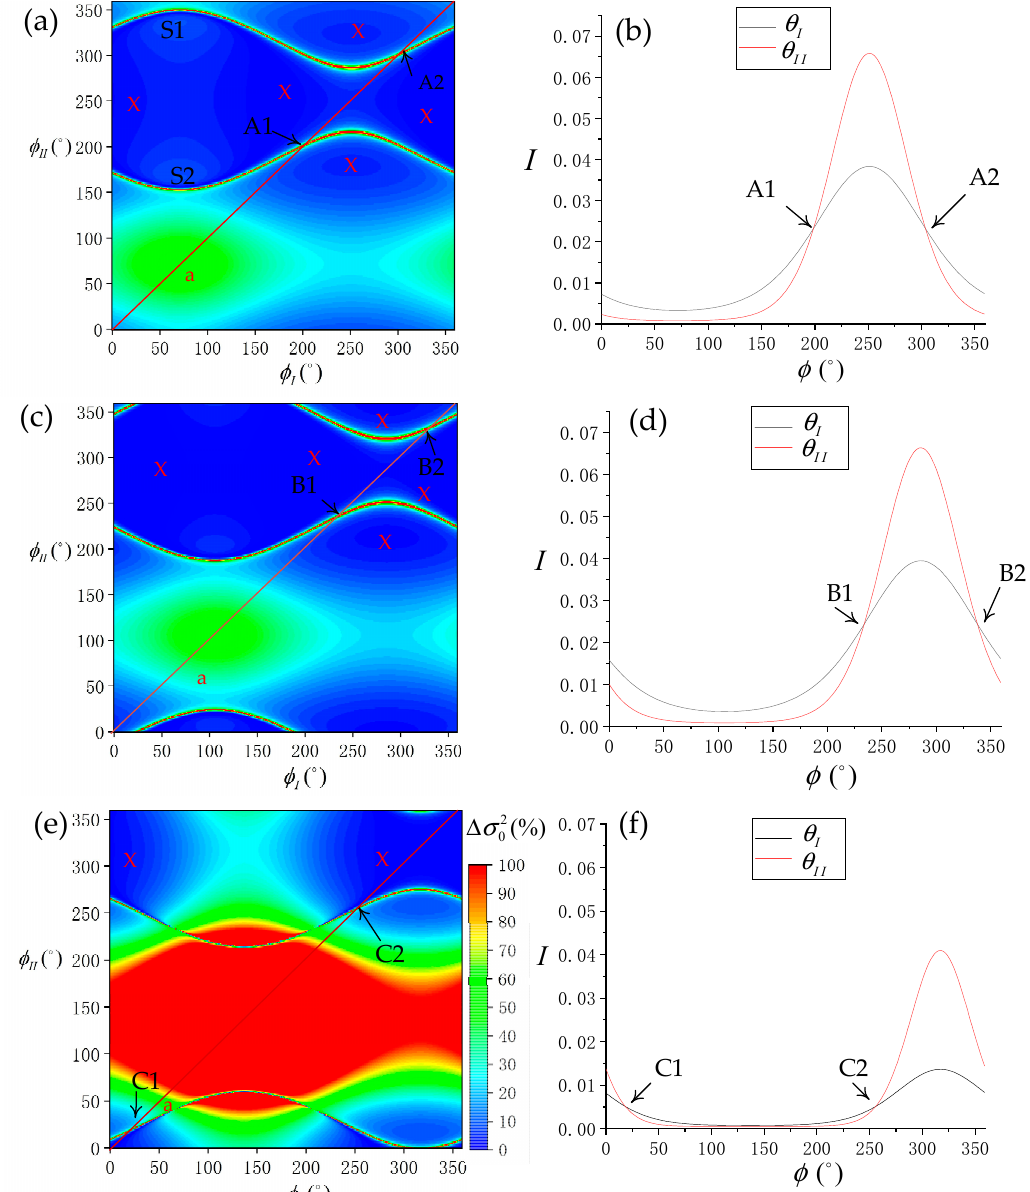
Figure 16. ( a ) Distribution of SSR estimation error ( ∆(cid:2026) (cid:2868)(cid:2870) ) at the simulation location [5° N, 120° E]. ( b ) The normalized SG radiance of the profile a in Figure 16a. ( c ) Distribution of SSR estimation error at simulation location [20° N, 120° E]. ( d ) The normalized SG radiance of the profile a in Figure 16c. ( e ) Distribution of SSR estimation error at simulation location [40° N, 120° E]. ( f ) The normalized SG radiance of the profile a in Figure 16f.